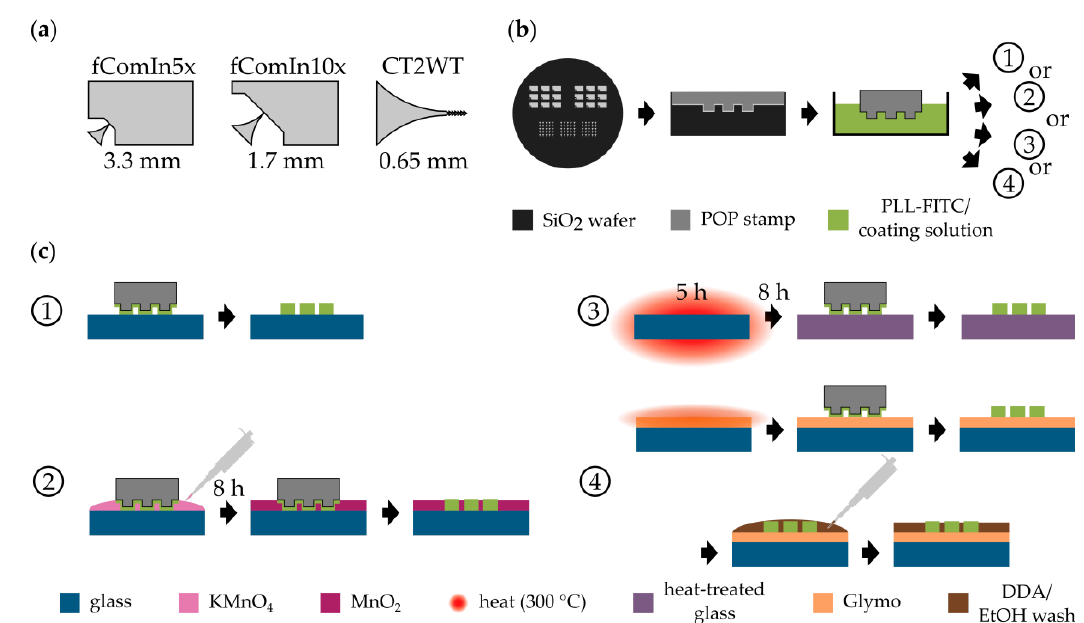
Figure 1. Modified µCP processes. ( a ) Different patterns for µCP used in this study of different sizes. ( b ) Generally applicable steps of µCP. The patterns are etched into a silicon wafer and the polymer is cast into the wafer. The hardened polymer is cut into stamps and the stamps are incubated in a coating solution. ( c ) Variants of µCP. Variant 1 is the standard process. The coating solution is transferred to an unmodified glass coverslip. In variant 2, the stamp is placed on the substrate and a KMnO 4 solution is applied to the substrate. After precipitation overnight, the stamp is removed, leaving the pattern surrounded by a layer of water insoluble MnO 2 . In variant 3, the glass coverslip is heated for 5 h and cooled overnight. The modified substrate is stamped like in variant 1. Here, the incubation step in (b) takes place just before the printing step. In variant 4, a Glymo monolayer is applied to the coverslip via CVD (chemical vapor deposition) and the coating is transferred to the Glymo layer. The substrate is either washed with EtOH or incubated in dodecylamine (DDA) and afterwards washed with EtOH so that unoccupied Glymo is bound.